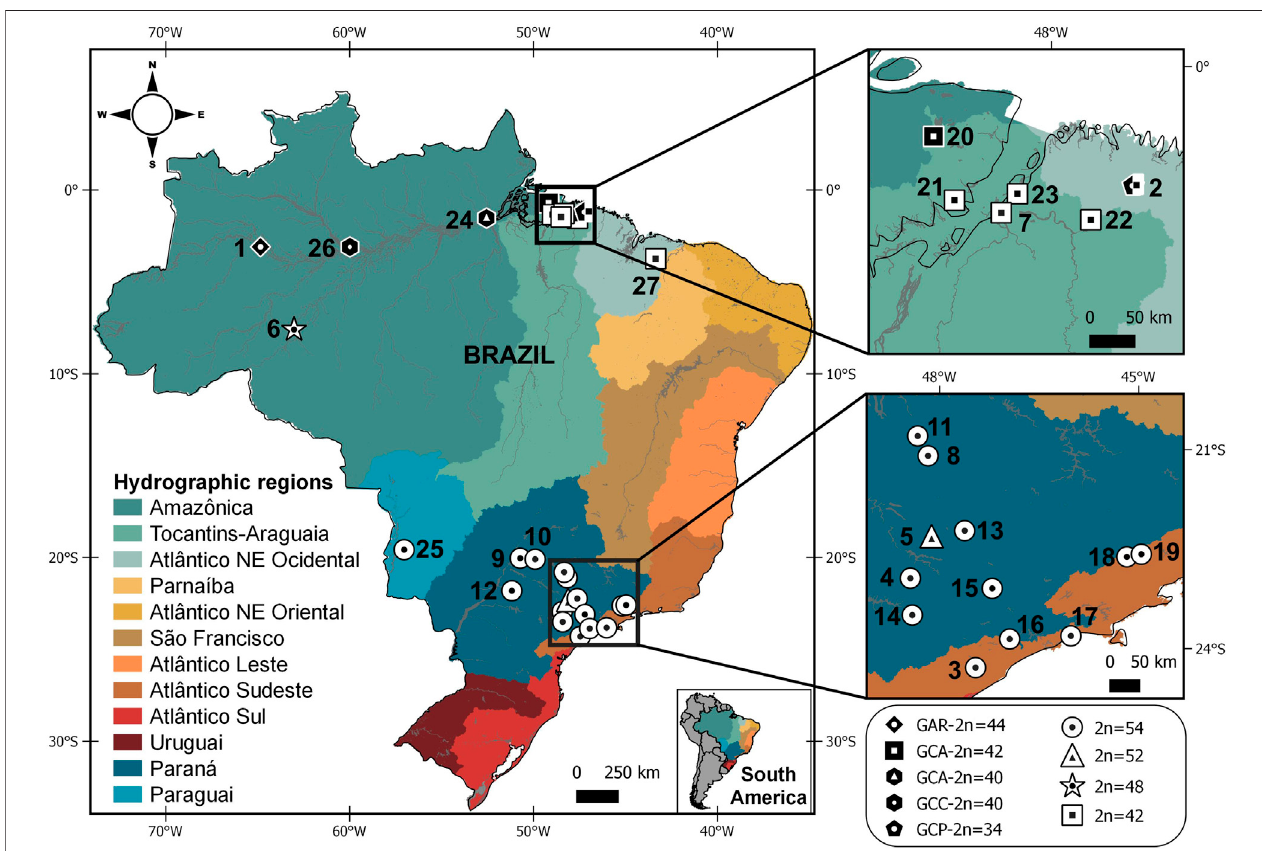
FIGURE1| MapshowingtheBrazilianhydrographicregionsandsamplepointsfor Gymnotusarapaima , G.capanema ,and G.carapo ,withkaryotypicinformation (2n=diploidnumber)fromthepresentstudyandfromtheliterature.Eachsymbolindicatesthekaryotypeobtainedfromthelocality;morethanonesymbolindicatesthat distinct karyotypes were collected at the same locality. Symbols in white denote specimens analyzed by classic cytogenetics; symbols in black denote specimens analyzedbychromosomepaintingwith G. carapo(2n=42)whole-chromosomeprobes( Table1 ;Nagamachietal.,2010;Nagamachietal.,2013;Machadoetal., 2018, and present study). The numbers refer to localities detailed on Table 1